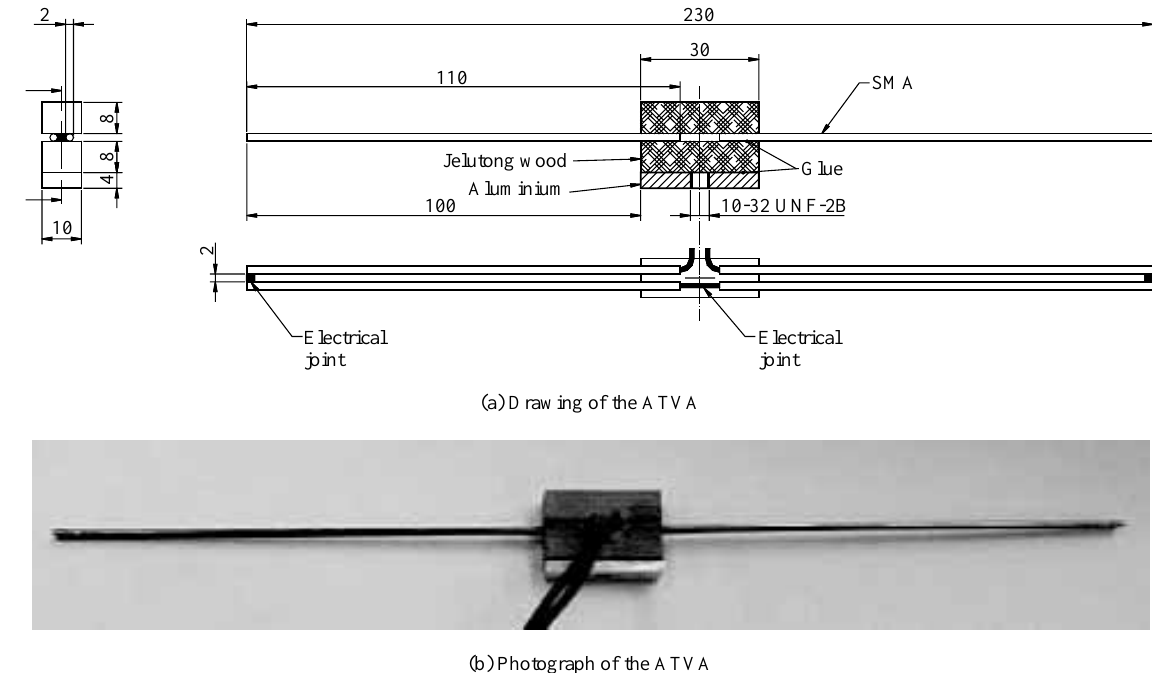
Fig. 9. Prototype shape memory alloy ATVA.